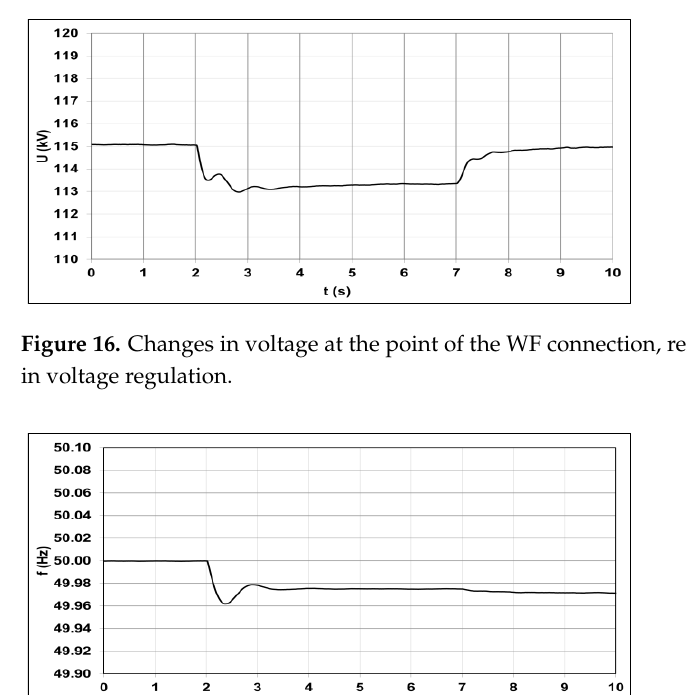
Figure 15. Reactive power changes in the system, resulting from the farm operation in the voltage regulation mode (the symbols used correspond to those in Figure 9).